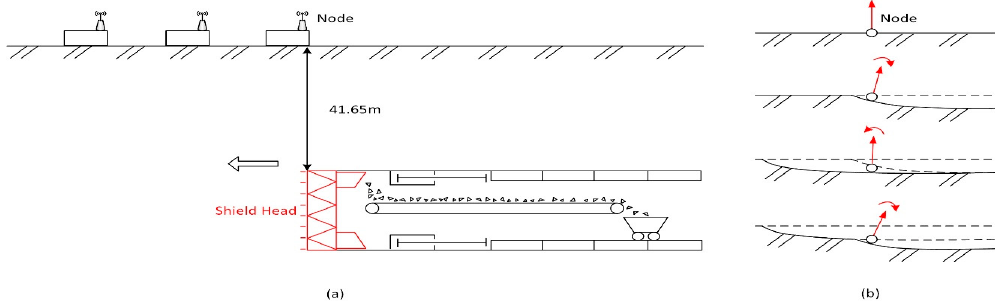
Figure 7. Schematic Diagram of Spatial Relation Between Sensors and the Shield Machine ( a ) and Expected Motion Stages of a Sensor Node Caused by Shield Tunneling ( b ) (modified from [11]).